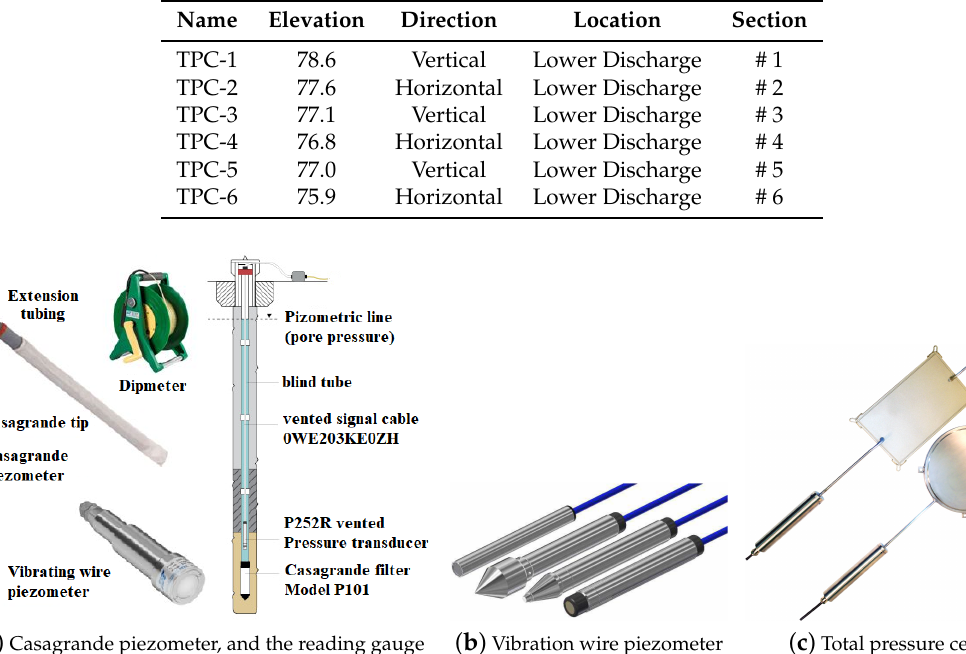
Figure 4. Sample of installed instruments in Boostan Dam; photos adapted from